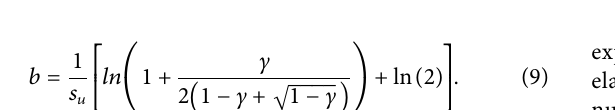
FIGURE 6 | AE magnitude of jointed and bolted jointed specimens under uniaxial compression: (A) 75 ° jointed specimen, (B) 75 ° bolted jointed specimen, (C) 45 ° jointed specimen, and (D) 45 ° bolted jointed specimen.